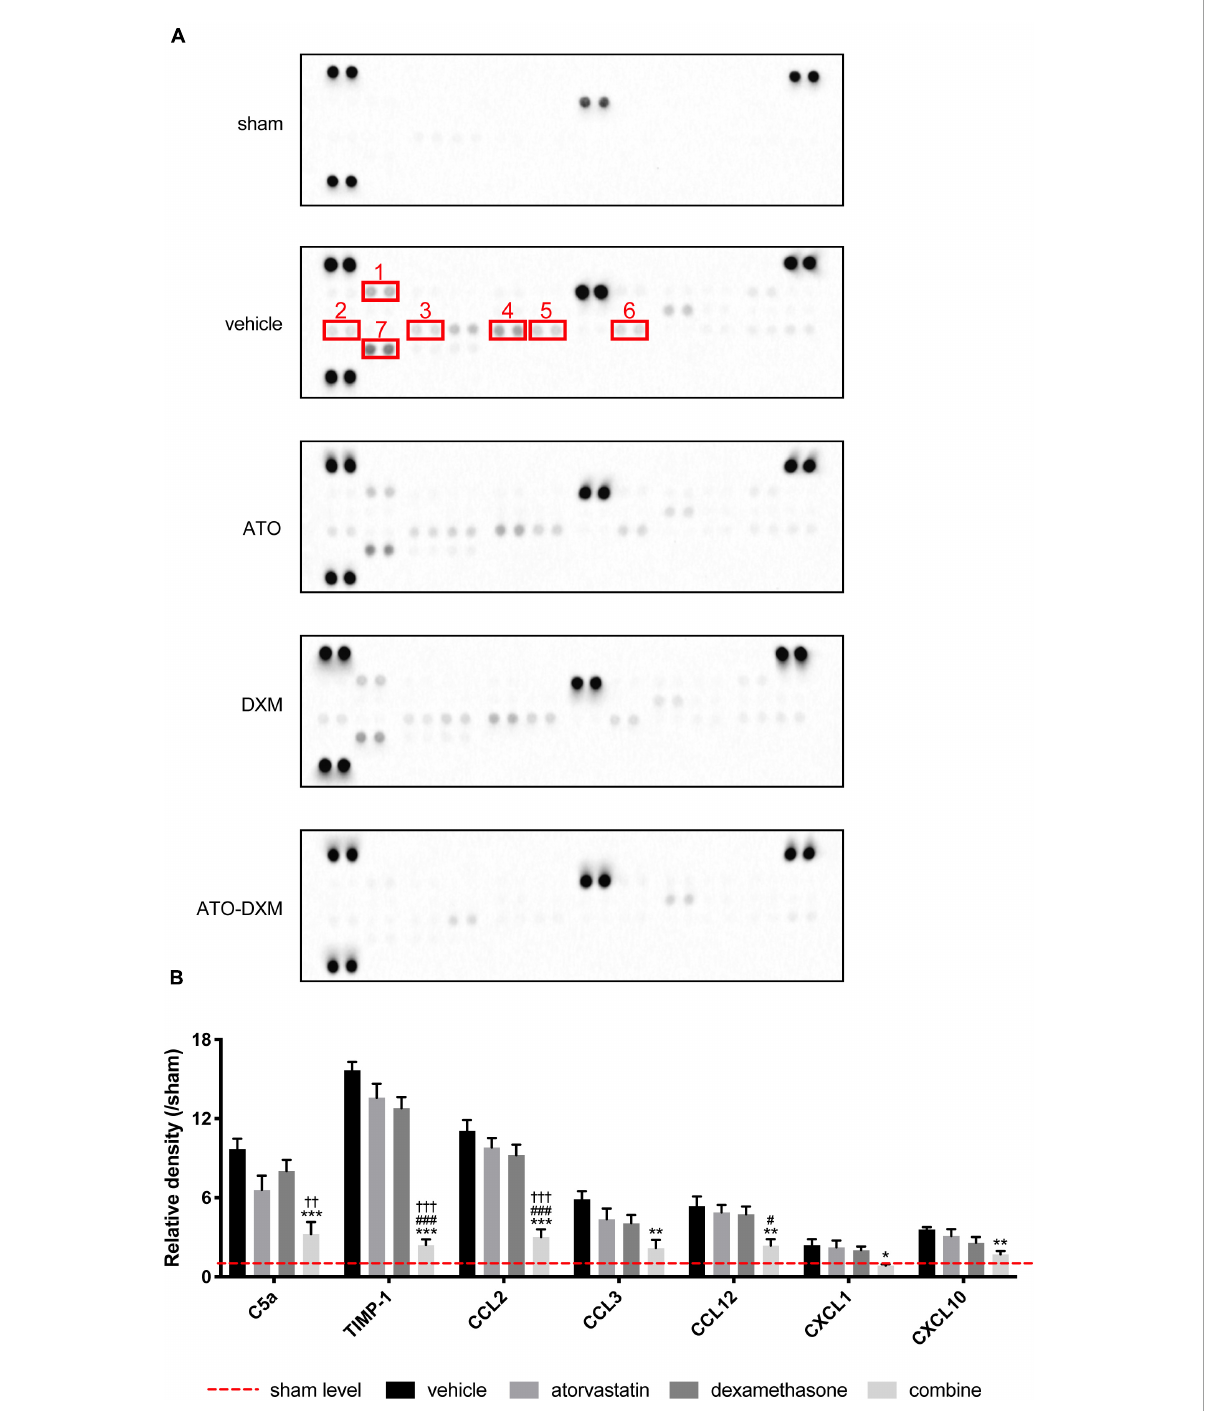
FIGURE6 Inflammatory cytokines in perihematomal tissues detected by cytokine array for 3 consecutive days after ICH. (A) Expression of inflammatory cytokines in each group, 1–7 representing C5a, CXCL10, CXCL1, CCL2, CCL12, CCL3, and TIMP-1, respectively. Each cytokine in a cytokine array was presented in duplicate, indicated by two adjacent black dots. (B) Statistical comparisons of inflammatory cytokines expressed as the relative density of inflammatory cytokine density of interest/corresponding inflammatory cytokine density in the sham group. * p < 0.05, ** p < 0.01, *** p < 0.001 vs vehicle group; # p < 0.05, ### p < 0.001 vs ATO group; †† p < 0.01, † † † p < 0.01 vs DXM